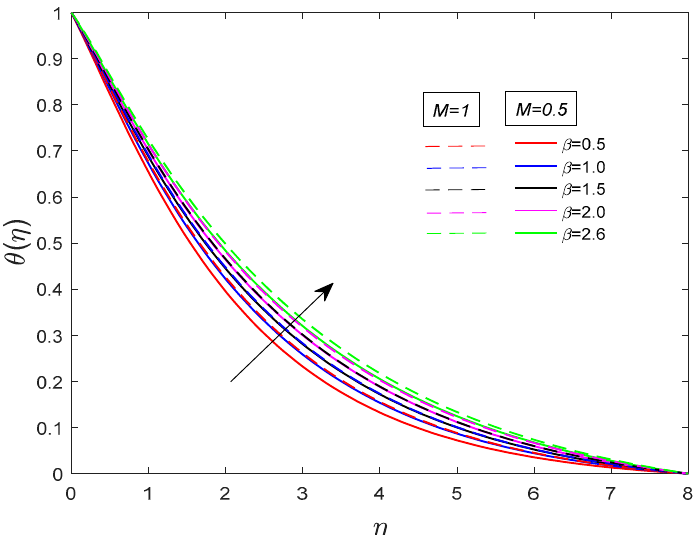
Figure 8. Effect of Maxwell fluid parameter ( β ) on temperature profile with Pr = Sc = 0.7, Ec = Kr = Sr = 0.1.